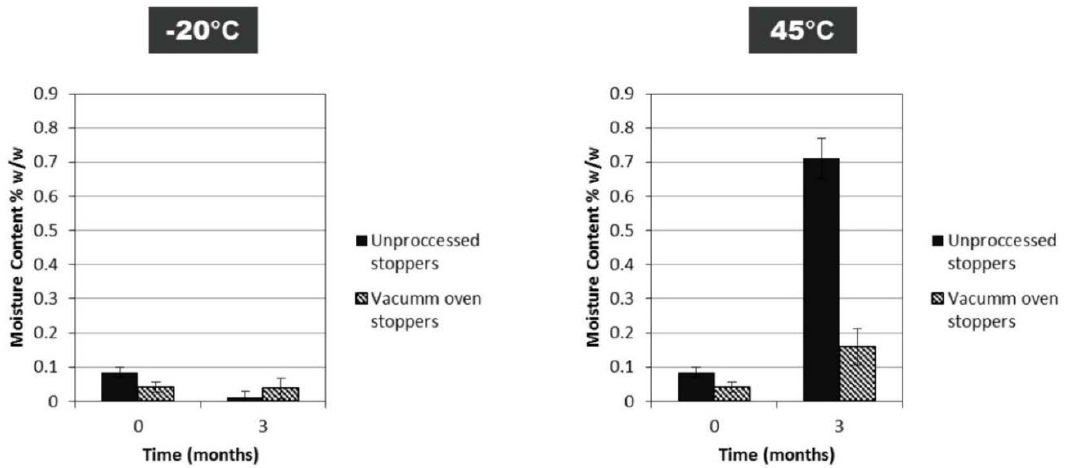
Figure 8. Di ff erence in moisture content for FD IgG (50 mg / mL) between vials with vacuum-oven-dried stoppers and vials with untreated stoppers straight out of packaging after 3 months of storage at − 20 ◦ C and 45 ◦ C ( n = 3 vial replicates).